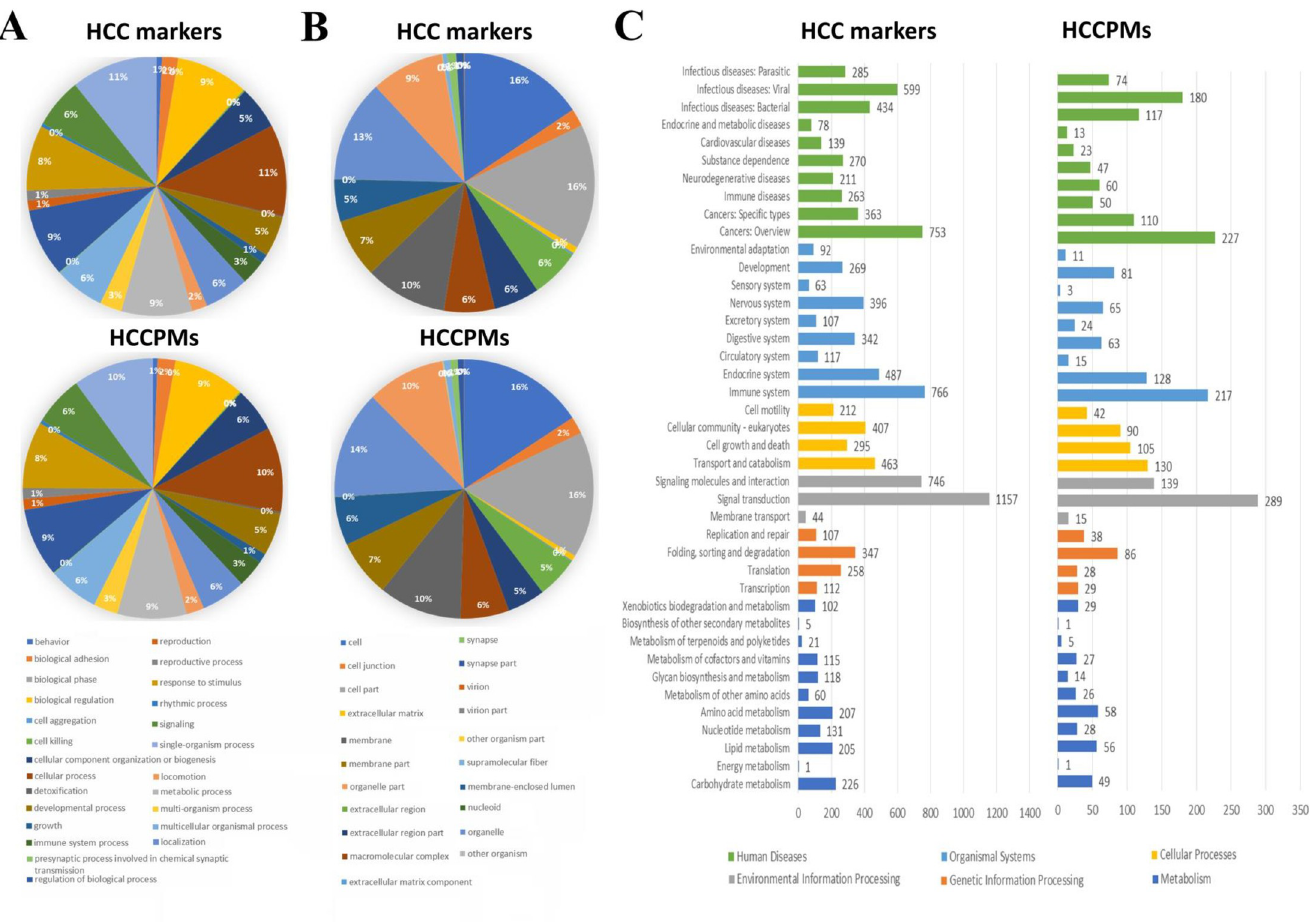
Fig 2. Functional analyses of HCC markers and HCCPMs. The distribution of HCC markers and HCCPMs functionally involved in Biological process (A) and Cellular component (B) was identified by GO enrichment analysis. (C) Based on KEGG analysis, the gene functions of HCC markers and HCCPMs were classified into Human Diseases, Organismal Systems, Cellular Processes, Environmental Information Processing, Genetic Information Processing, and Metabolism.